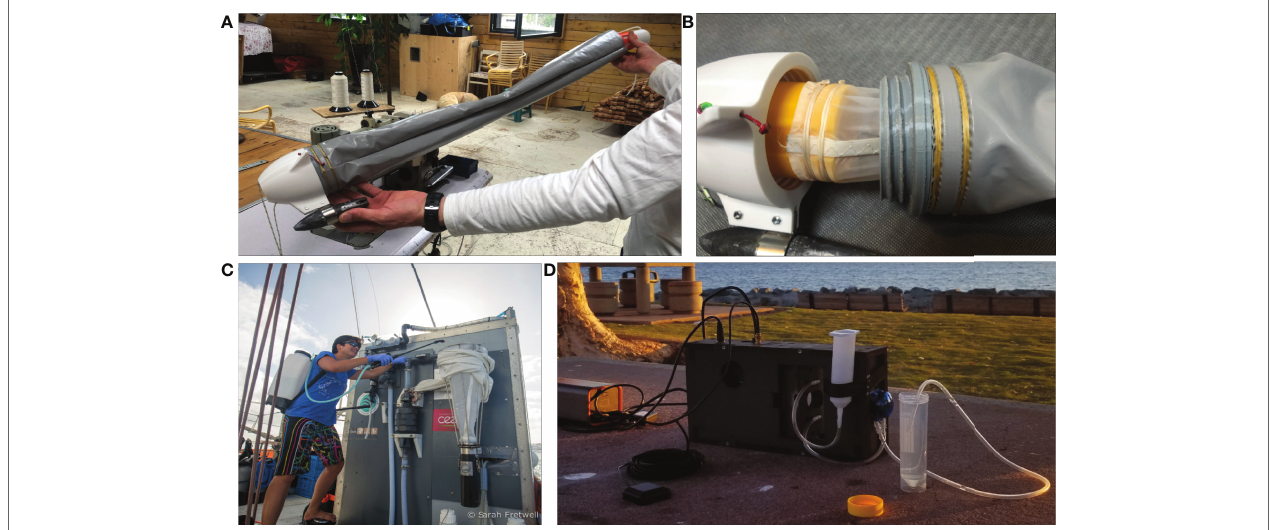
FIGURE 1 | (A) The ‘ Coryphaena ’ high speed net, able to collect plankton >50µm at speed up to 11 knots. (B) The 50µm mesh in the Coryphaena is supported and protected externally by a 200µm mesh allowing for greater strength, as well as an impermeable skirt (gray) improving the flow of water into the net by Venturi effect. (C) The Decknet (DN) pumping and filtration system installed on board Tara . (D) The PlanktoScope allowing quantitative imaging of